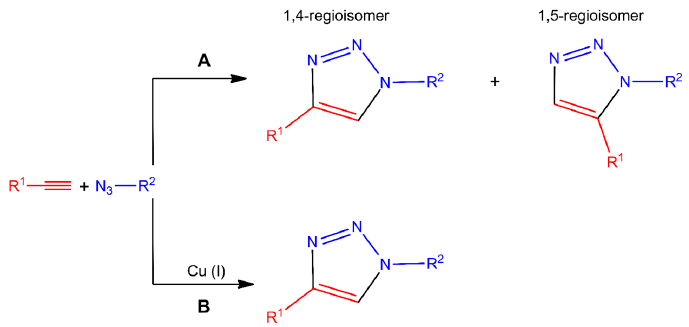
Figure 2. Huisgen cycloaddition reactions in the absence ( A ) or presence ( B ) of Cu(I) catalyst.